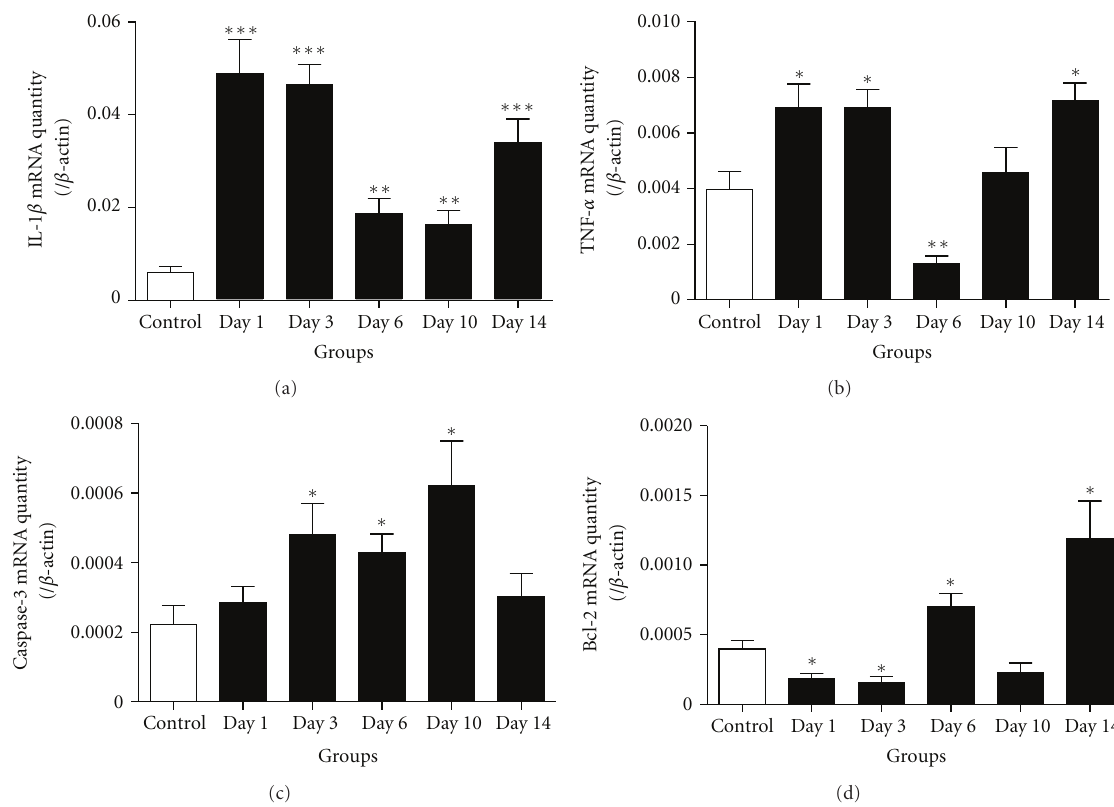
Figure 5: The mRNA levels of NF- κ B downstream genes were detected by real-time PCR in brain cortex after SAH. (a) IL-1 β gene expression was significantly increasing after SAH ( P < 0 . 05) and showed a biphasic increasing. Day 1, day 3, and day 14 groups showed the highest expression; (b) TNF- α gene showed biphasic expression in day 1, day 3, and day 14 groups; (c) caspase-3 gene significantly increased in day 3, day 6, and day 10 groups ( P < 0 . 05), and the expression also showed two peaks on day 3 and day 10; (d) Bcl-2 gene expression was inhibited after SAH. In day 1 and day 3 groups, Bcl-2 was decreased significantly ( P < 0 . 05), and in day 6 and day 14 groups, Bcl-2 was obviously increased ( P < 0 . 05). ∗ P < 0 . 05, ∗∗ P < 0 . 01, and ∗∗∗ P < 0 . 001 versus control group. Bars represent the mean ± SEM ( n = 4, each